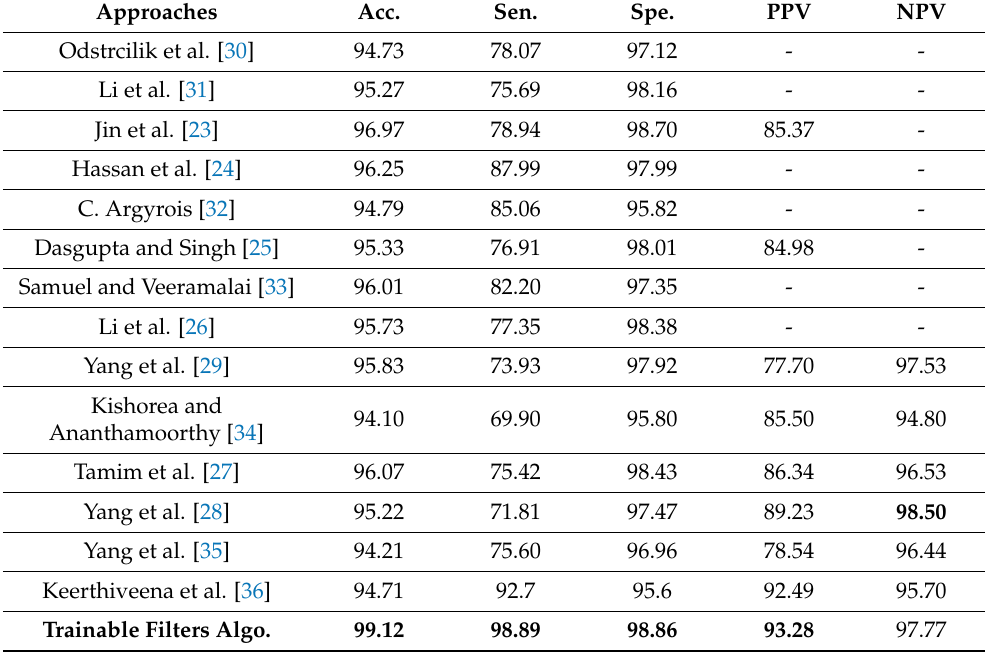
Table 3. Performance comparison of the proposed algorithms with state-of-the-art vessel segmenta- tion approaches on the DRIVE dataset.